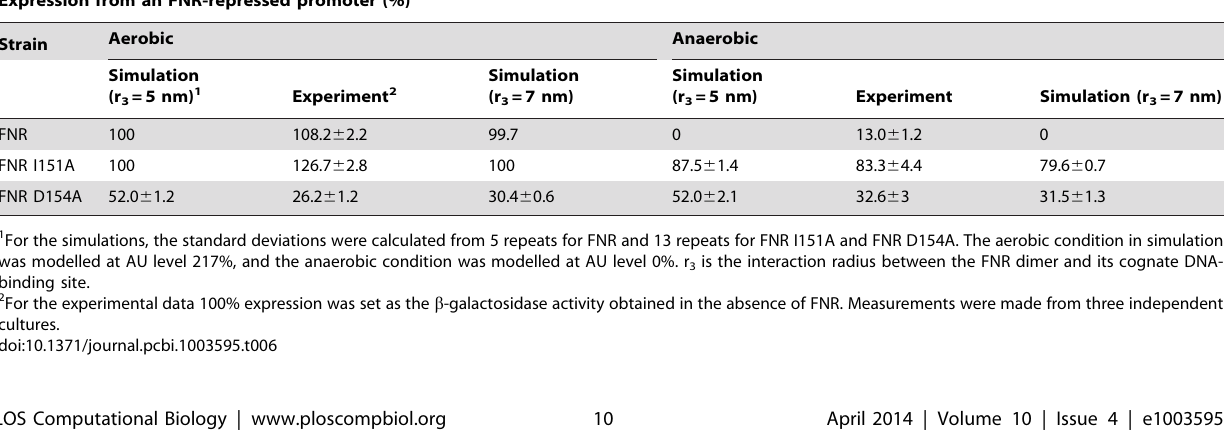
Table 6. Comparison between experimental and simulation results for FNR variants.